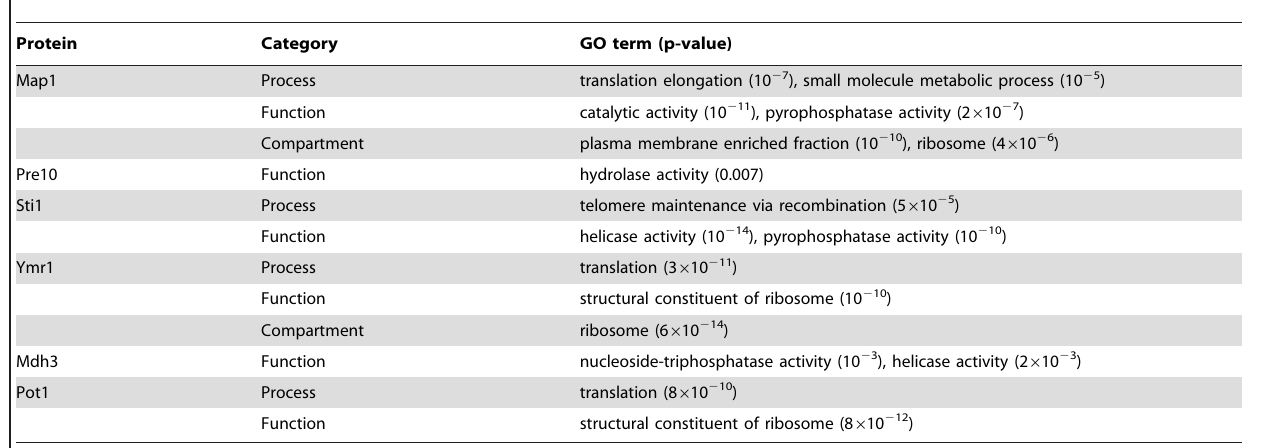
Table 2. Selected list of GO terms enriched among mRNA targets.